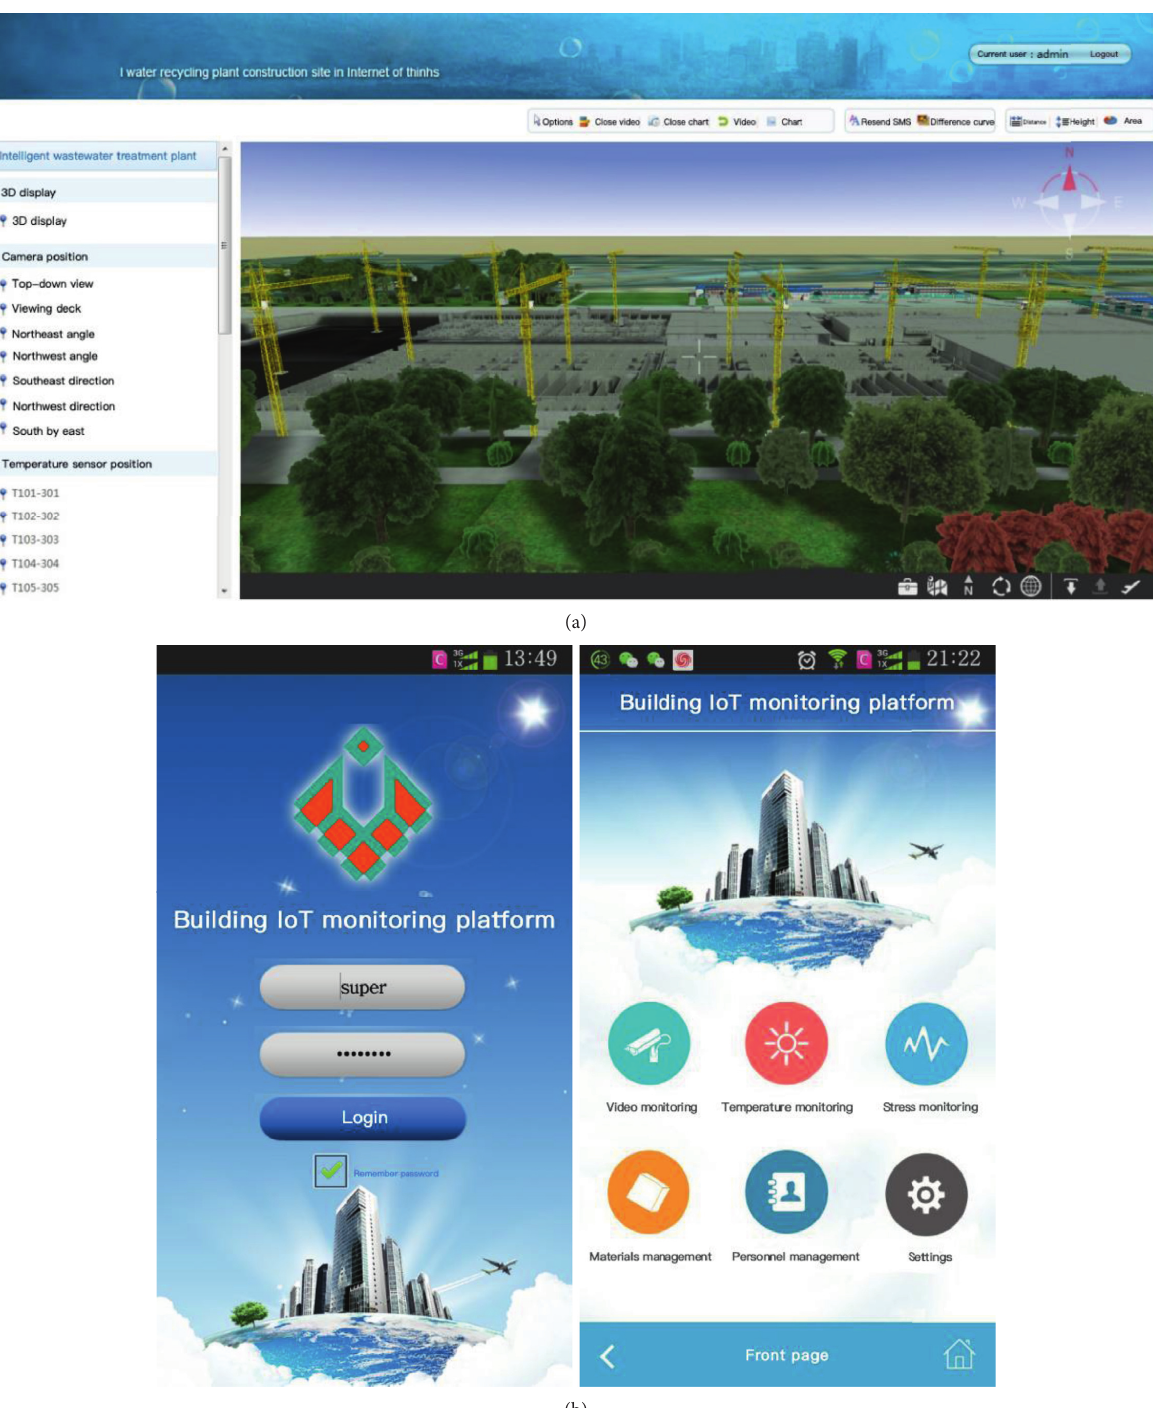
Figure 4: IoT management platform: (a) web terminal; (b) smartphone app mobile